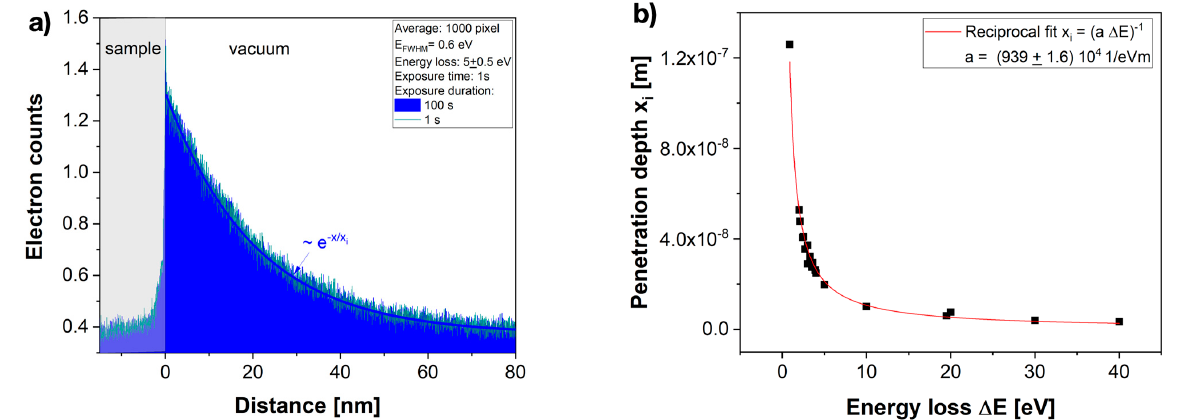
Figure 6. Energy-dependent penetration depth of the evanescent field. ( a ) The average electron count at the interface was about 1 electron. The intensity decay was strictly exponential I (0) e − x/xi with a characteristic distance x i that we determined with a least square fit procedure for various energy losses to obtain the data set of Figure 6b. The effect was independent of the recording time. ( b ) A reciprocal dependence of x i on energy loss was revealed. In this case, a fitting parameter, a, could be determined and compared to the propagation of wave packets at light speed by the elemental constant ℏ c = 197 eVnm > 106 eVnm = ℏ v = 1/a.